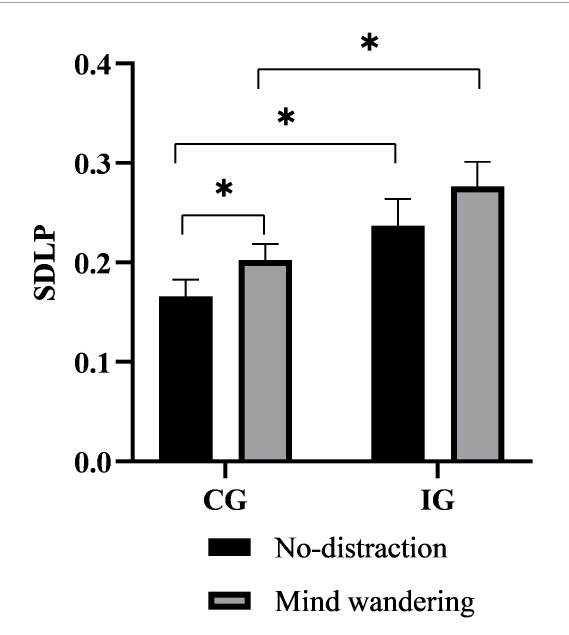
FIGURE4 The effect of mind wandering (MW) on the SDLP. ∗∗∗ P < 0.001; ∗∗ P < 0.01; ∗ P < 0.05. MW, mind wandering; SDLP, standard deviation of lateral position; IG, insomniac group; CG, control group.